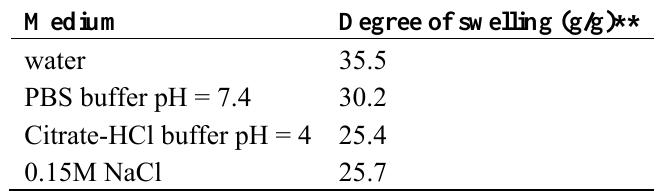
Table 3. Swelling of chitosan-methylcellulose co-gel * at different pH.